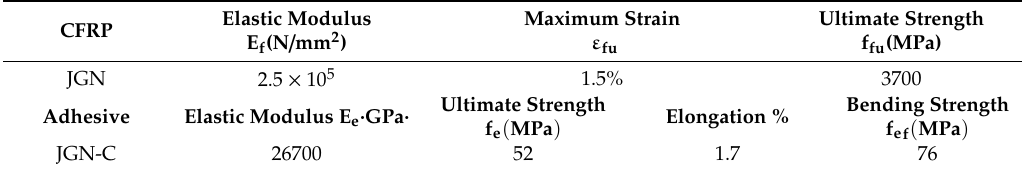
Table 1. Mechanical parameters of the CFRP and adhesive.